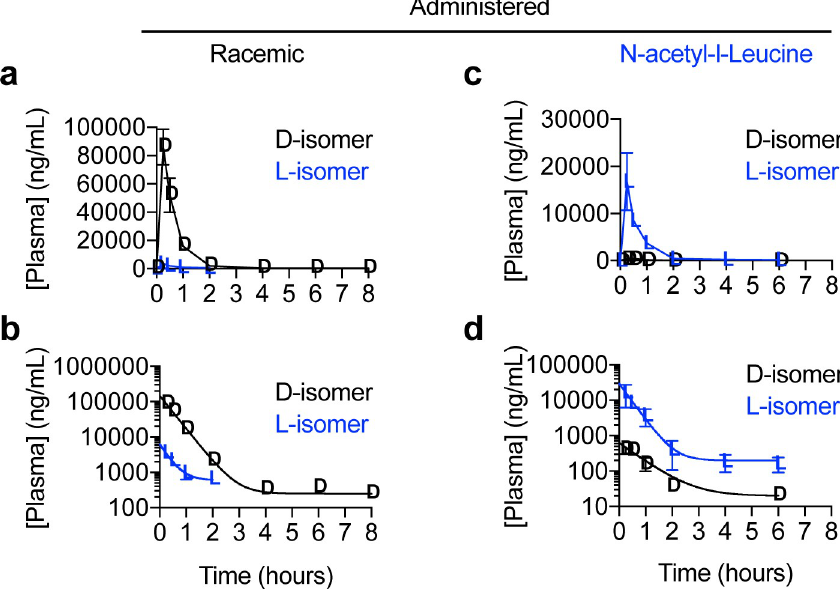
Fig 3. Graphs of plasma concentration of enantiomers versus time after administration of racemic N-acetyl-DL- leucine or purified N-acetyl-L-leucine. Data are presented as ( a,c ) linear-linear plots or ( b,d ) semilog plots. Values are the mean ± standard error of the mean with n = 3 (mice).